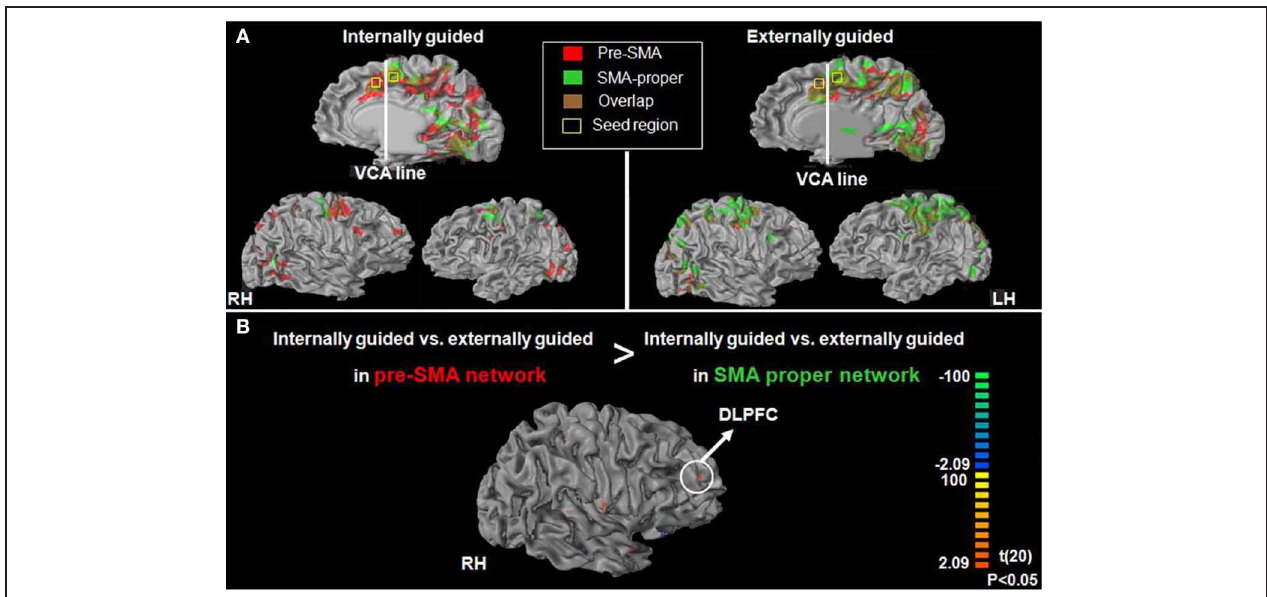
FIGURE 5 | Group functional connectivity networks presented on inflated brain. (A) Probability maps of the results driven by SMA proper (green network) and pre-SMA (red network) during internally (A-left